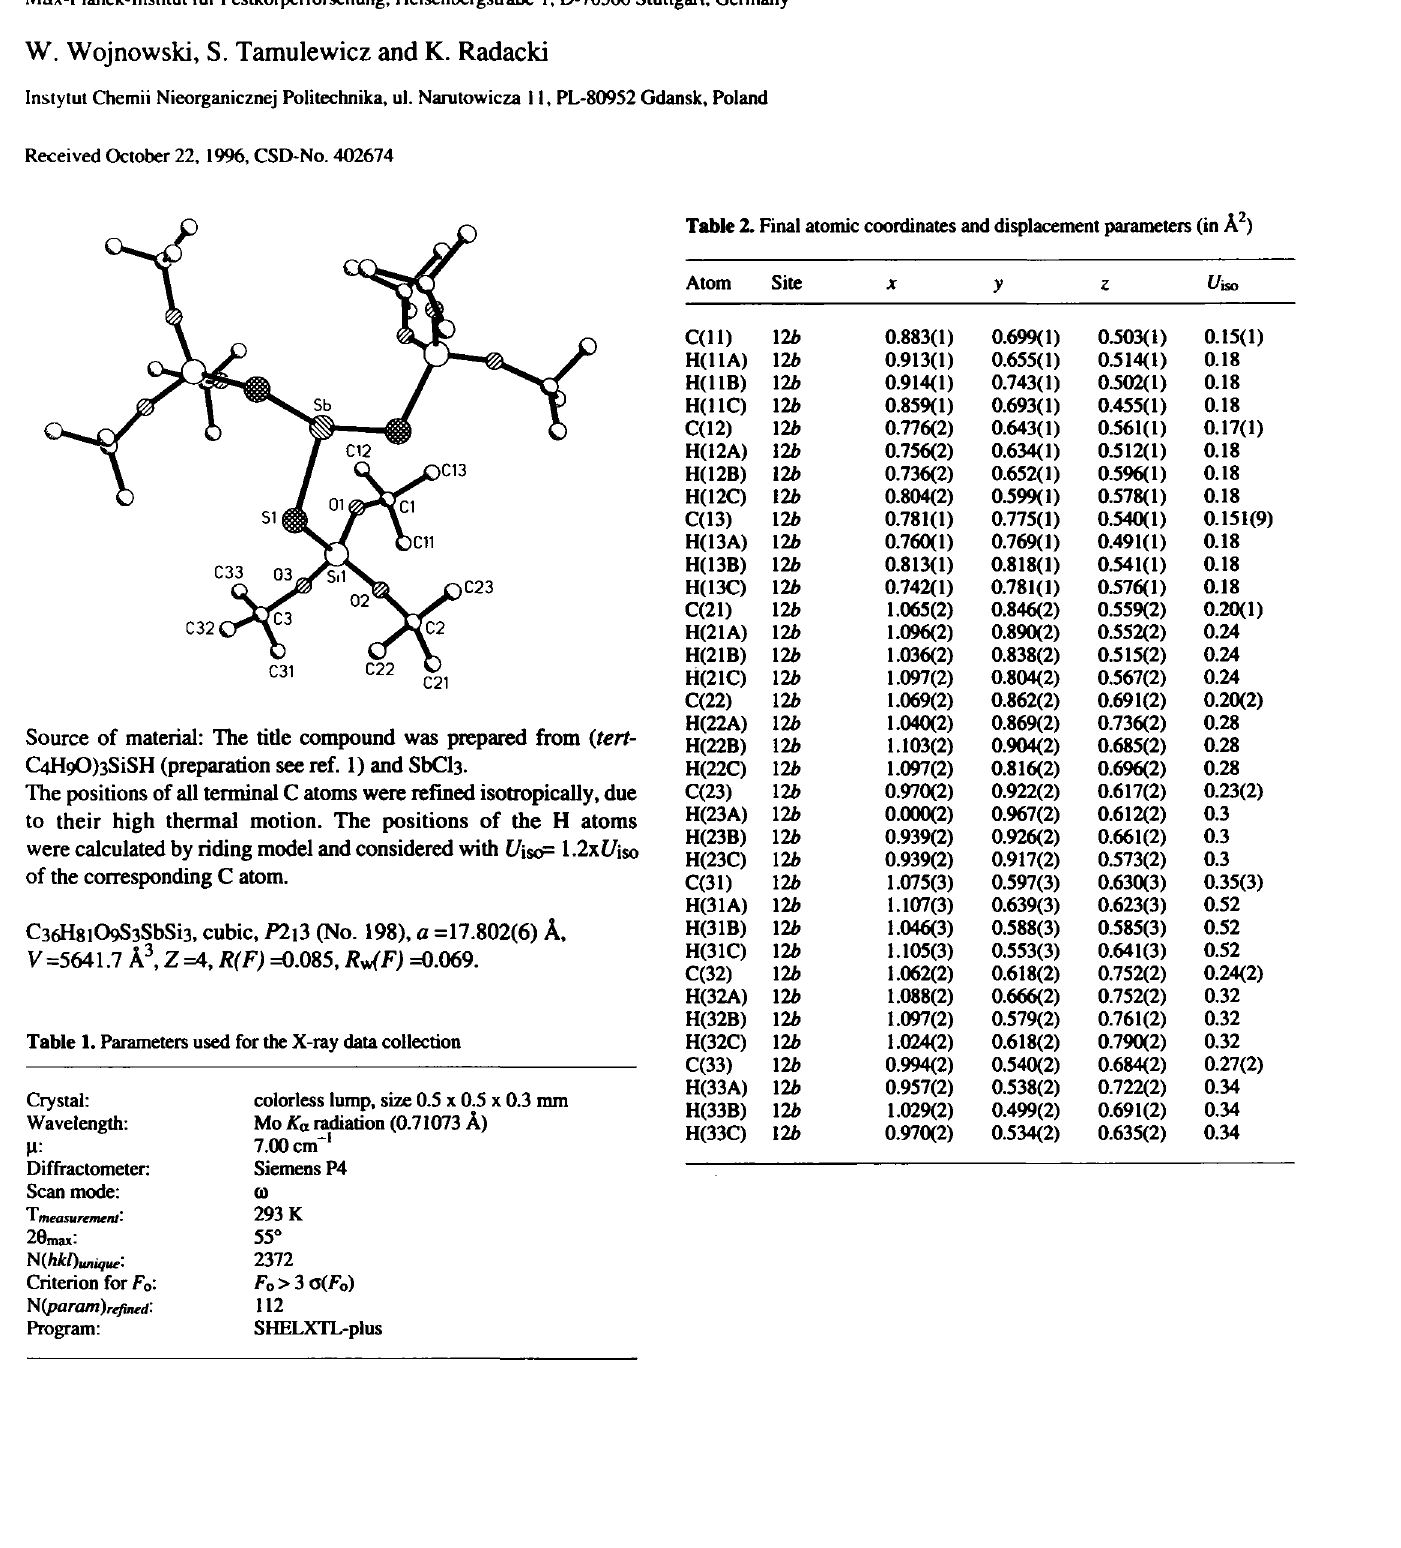
Table 2. Final atomic coordinates and displacement parameters (in Â 2 )